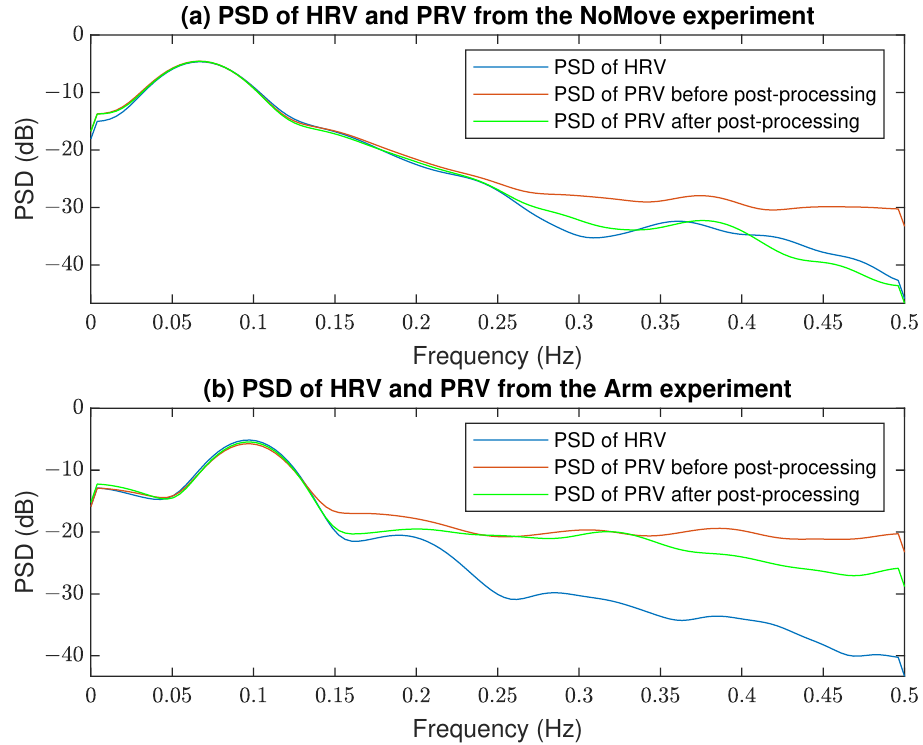
Figure 7. Comparison of the PSD of HRV and PRV before and after post-processing from the ( a ) NoMove and ( b ) Arm experiments, person